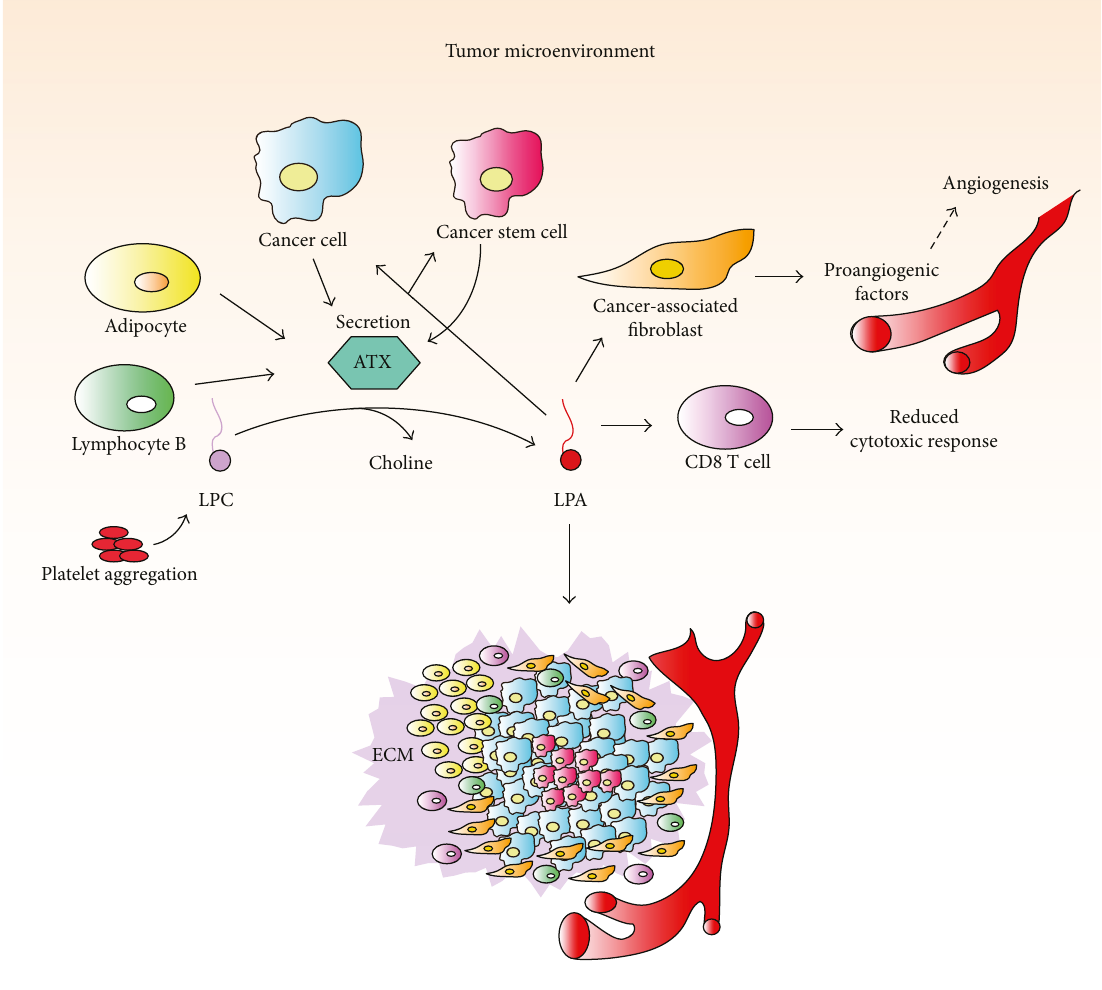
Figure 4: ATX-LPA signaling in tumor microenvironment. ATX hydrolyzes LPC to produce LPA from circulating LPC and platelet-derived LPC. ATX is mainly released into the tumor microenvironment by tumor-adjacent adipocytes and B lymphocytes but cancer cells and cancer stem cells also secrete this enzyme. LPA signals through its receptors to induce proliferation and invasion in cancer cells and cancer stem cells. LPA signaling induces angiogenesis through the recruitment of CAFS; it also reduces cytotoxic immune response via CD8 T cells. ECM (extracellular